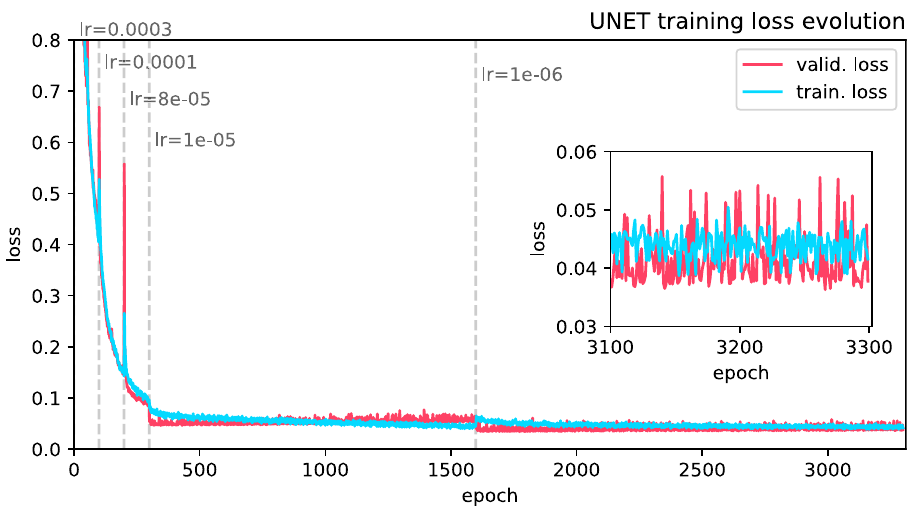
Figure 4. Overlapping objects. Left: raw image with object contours (green) produced though a sobel filter and morphological operations. Right: Annotations representing the individual annotation groups with the background in white.